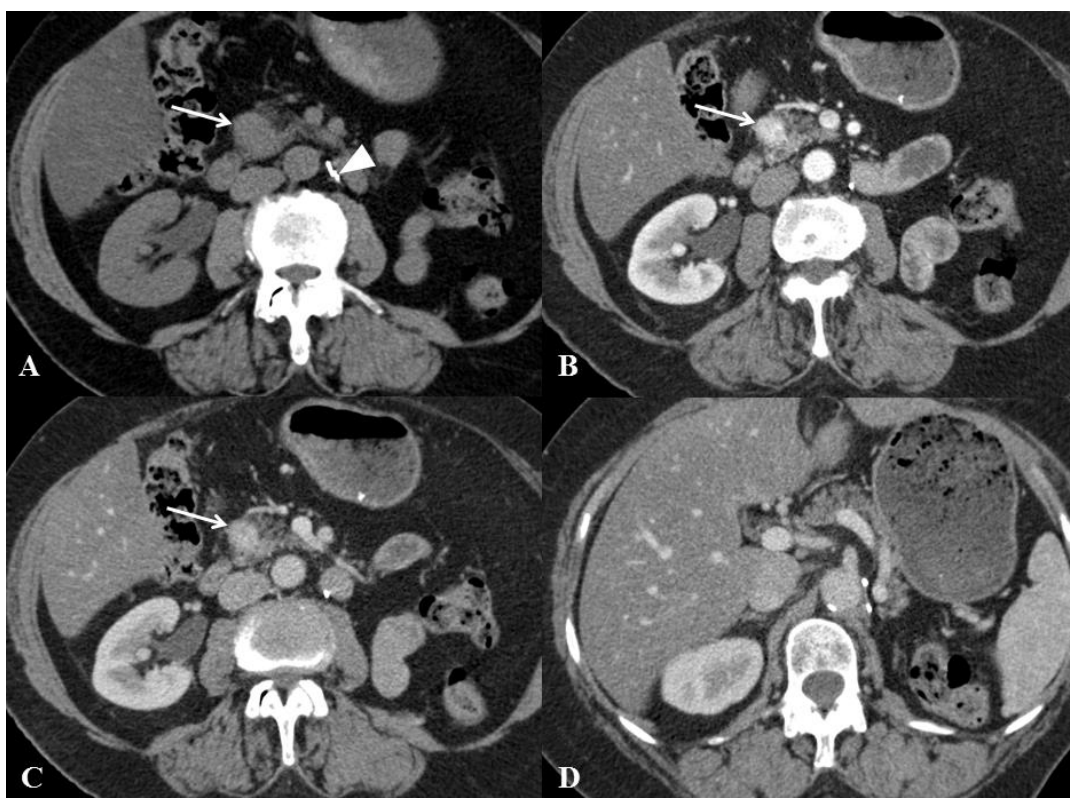
Figure 2. Computed tomography (CT) examination in a 73-year-old woman with prior history of renal cell carcinoma treated by total right nephrectomy four years before. ( A ) Plain CT image of the abdomen in the axial plane shows homogeneous, rounded mass (arrow) of the pancreatic head. No calcifications are present. Metallic clips (arrowhead) indicate prior nephrectomy. ( B ) CT image of the abdomen in the axial plane obtained during the arterial phase of enhancement shows homogeneous, enhancing, purely solid tumor (arrow) of the pancreatic head. ( C ) CT image of the abdomen in the axial plane obtained during the portal venous phase of enhancement shows homogeneous, purely solid tumor (arrow) of the pancreatic head. ( D ) At upper level, CT image shows no Wirsung duct enlargement and no intrahepatic bile duct dilatation. Endoscopic ultrasound-guided biopsy of the pancreatic mass revealed metastasis from renal cell carcinoma. After exclusion of local recurrence and other metastatic sites, the patient underwent pancreaticoduodenectomy (Whipple procedure).